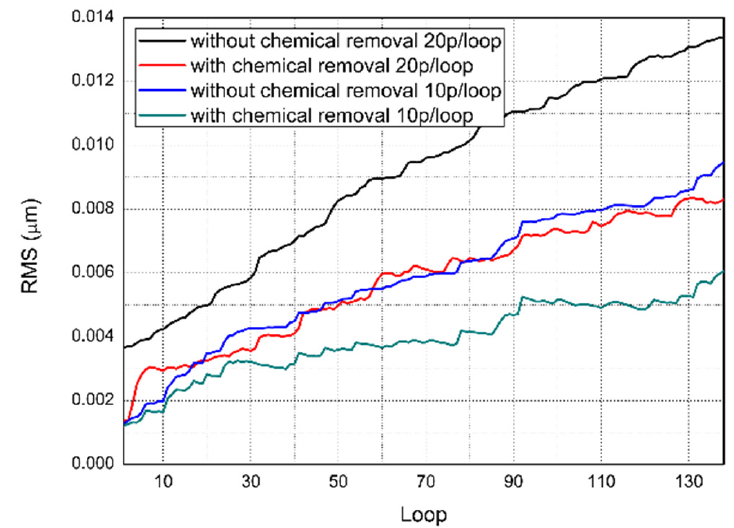
Figure 5. Simulated RMS roughness evolution with and without chemical material removal for 150 loops. The red and black solid lines are for 20 randomly selected particles, which are randomly placed for each loop (3000 in total), and the blue and green solid lines are for 10 randomly selected particles, which are randomly placed for each loop (1500 in total).